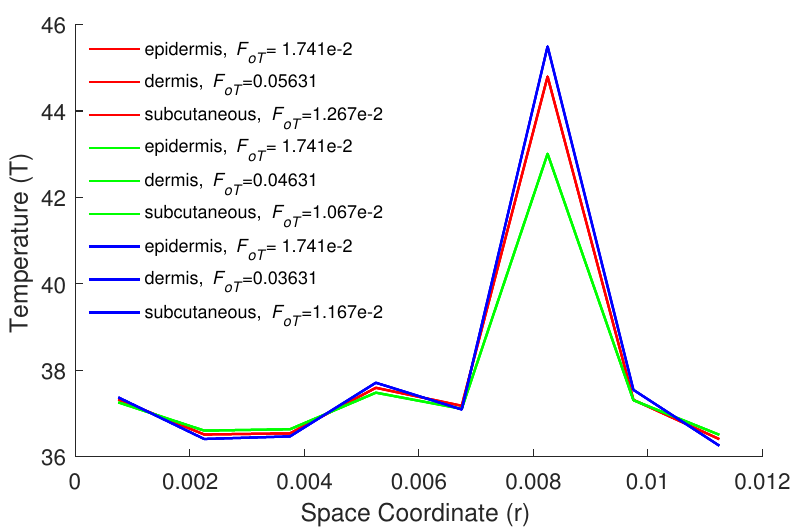
Figure 6. Temperature distributions for different values of F ot and F oq = 69.638, 0.7883, and 1.773 × 10 − 2 .